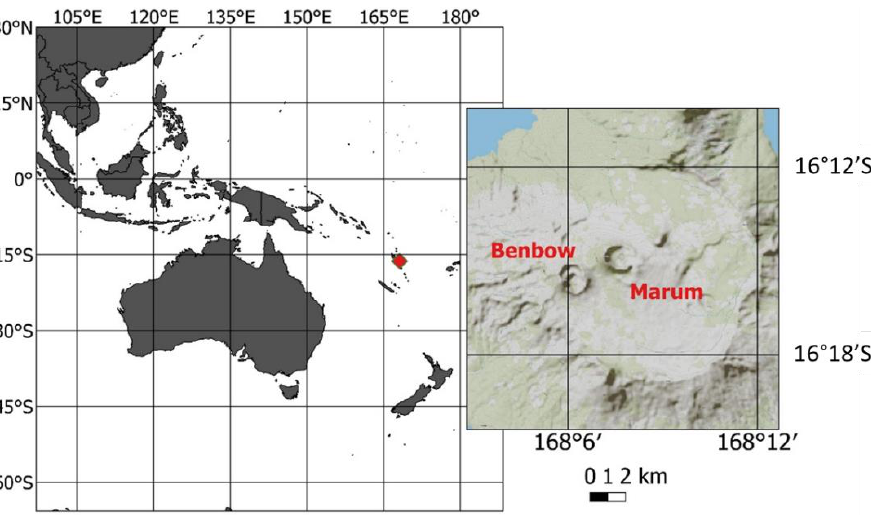
Figure 1. Geographic location of the Ambrym (Vanuatu) volcano, with indications marking the locations of the Benbow and Marum craters (right panel), which were the sites of recent lava lakes.